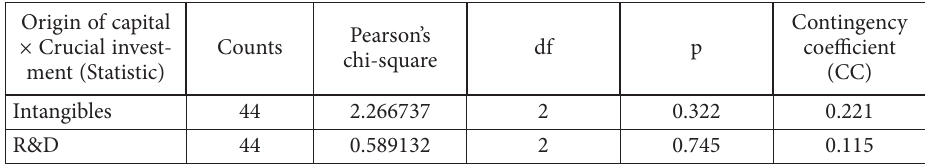
Table 12. Contingency: origin of capital × crucial investment – statistics (source: own) Origin of capital Contingency Pearson’s × Crucial invest- Counts df p coefficient chi-square ment (Statistic) (CC) Intangibles 44 2.266737 2 0.322 0.221 R&D 44 0.589132 2 0.745